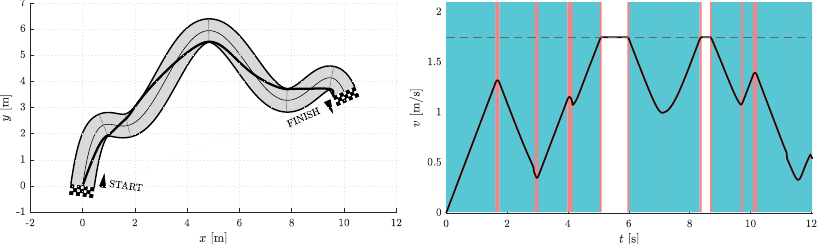
Figure 8. Resulting path as optimization result for N free = 2 and N seg = 2 ( left ) with the correspond- ing velocity profile ( right ). Blue vertical bands indicate intervals where the acceleration reaches its maximum allowable values. Similarly, red vertical bands indicate intervals where the jerk reaches its maximum allowable value.